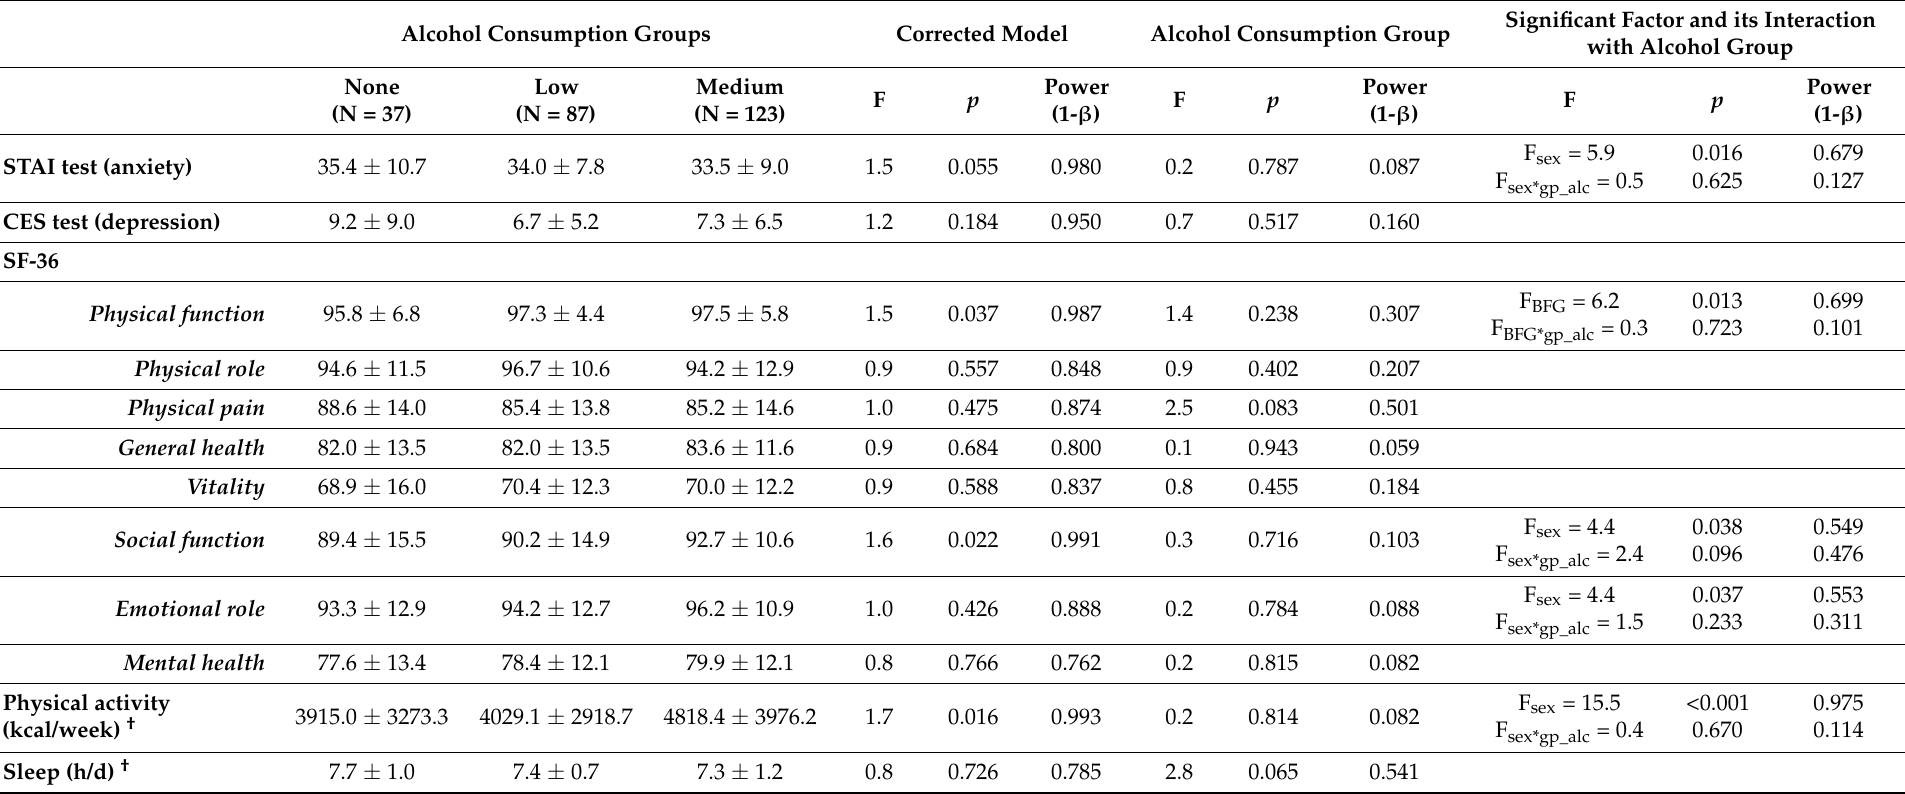
Table 5. Scoring of mental health and quality of life measures according to alcohol consumption groups. Alcohol Consumption Groups Corrected Model Alcohol Consumption Group